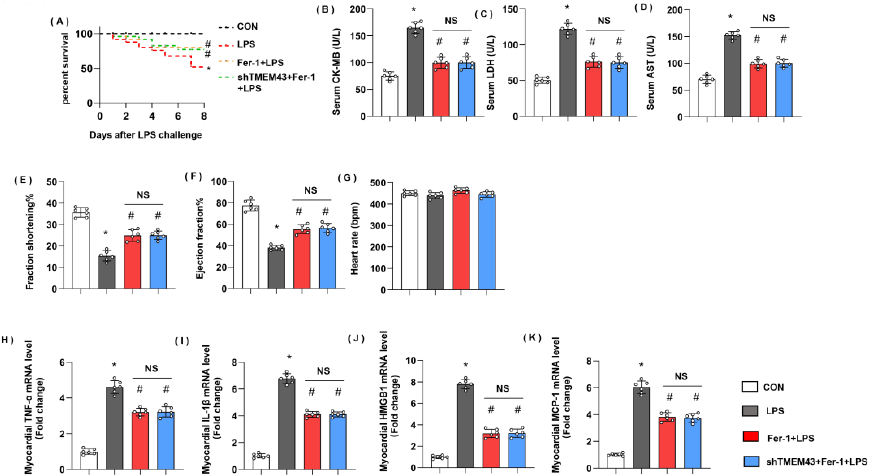
Figure 10. Ferrostatin-1 blurs TMEM43 knockdown-induced aggravating effects in vivo. Mice were